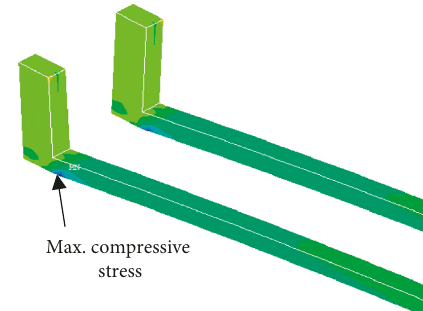
Figure 8: Normal stresses in concrete arches of HCB2 due to stop